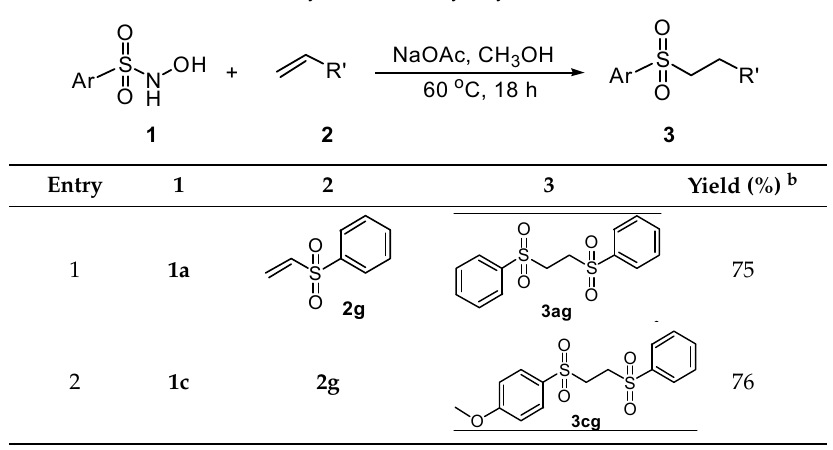
Table 3. Synthesis of alkyl aryl sulfones a .